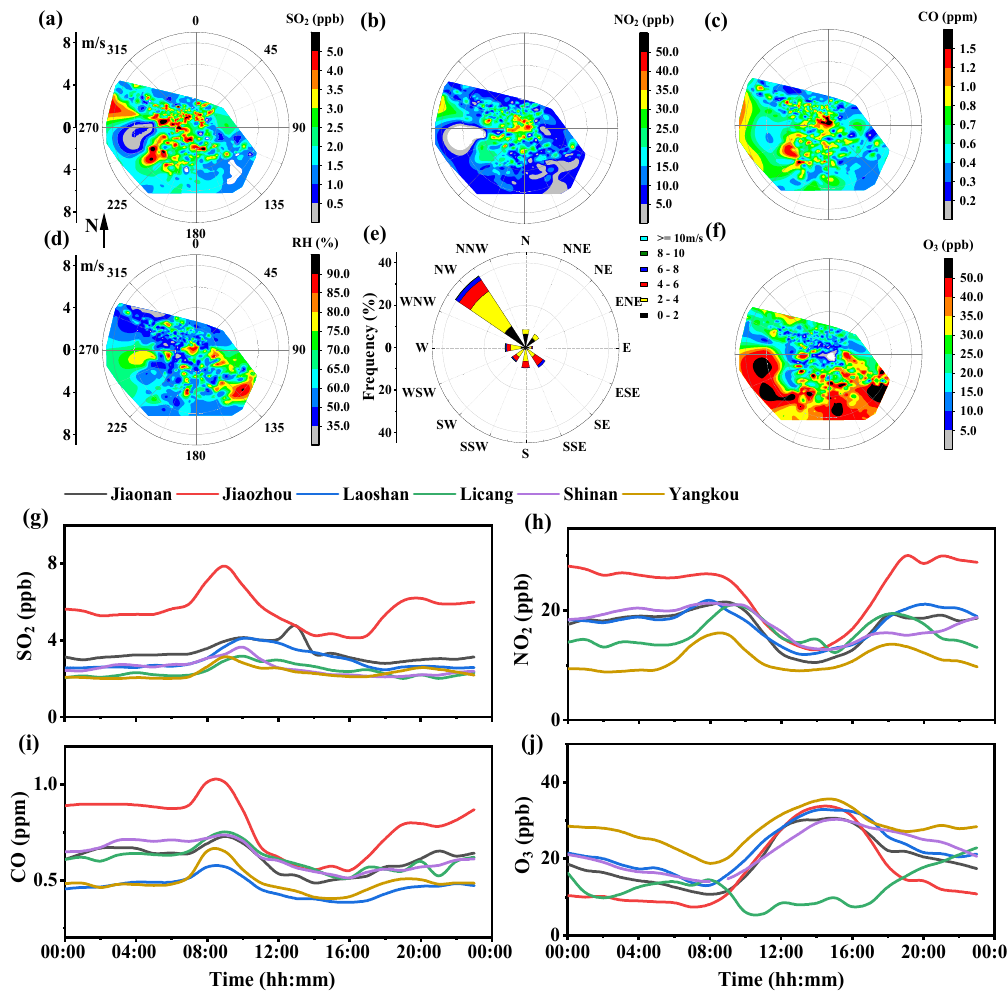
Figure 4. Dependence map of gas concentration and RH on wind speed and direction ( a – f ); diurnal variation of SO 2 , NO 2 , CO, and O 3 (hourly average) in Jiaonan (JN), Jiaozhou (JZ), Laoshan (LS), Licang (LC), Shinan (SN), and Yangkou (YK) during the measuring process ( g – j ).